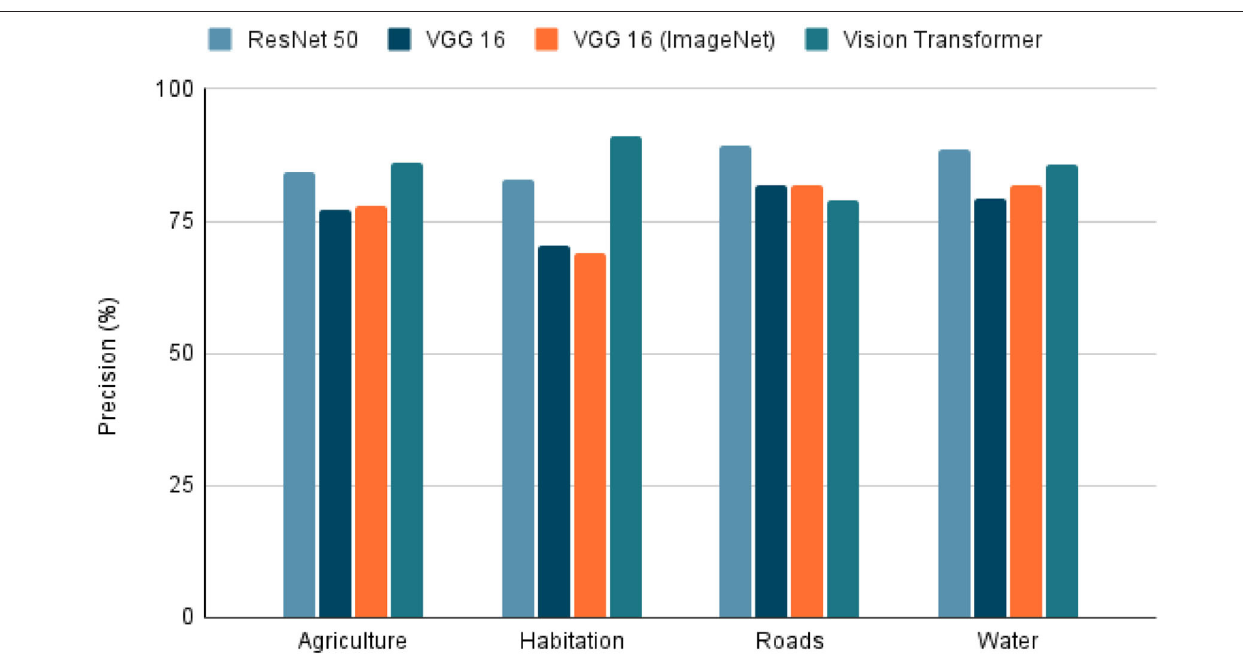
security in the Department of Cauca, Colombia. The dataset is structured according to the four-dimensional model of food security proposed by FAO (2). It allows the calculation of a